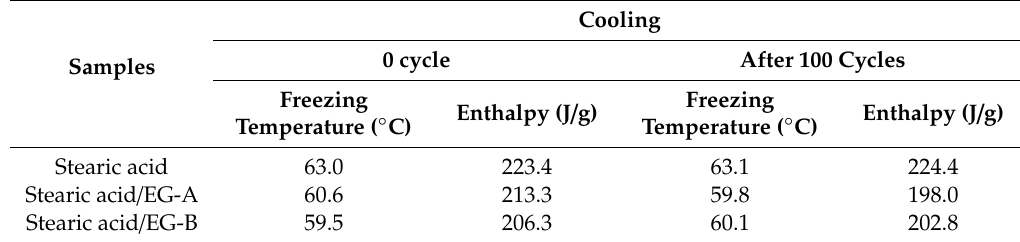
Table 2. DSC data of stearic acid and stearic acid / EG composites during cooling.